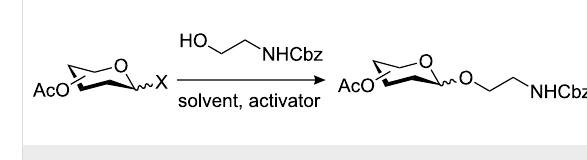
of the azido group [13,14]. Alternatively, the carbohydrate